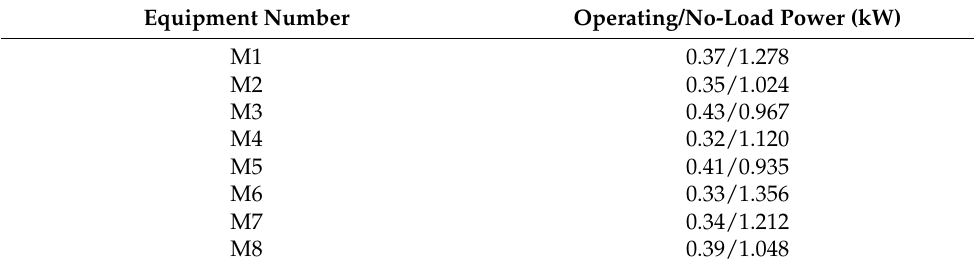
Table 9. The equipment information.